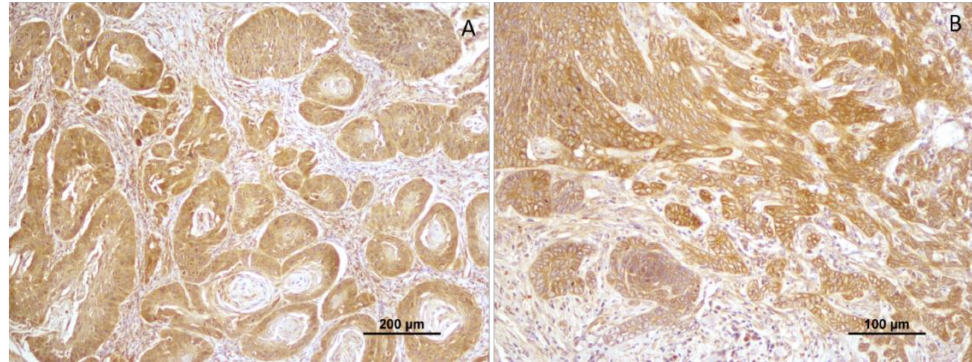
Figure 3. ( A , B ) Positive CTEN immunoreactivity in moderately differentiated tumors (grade II).